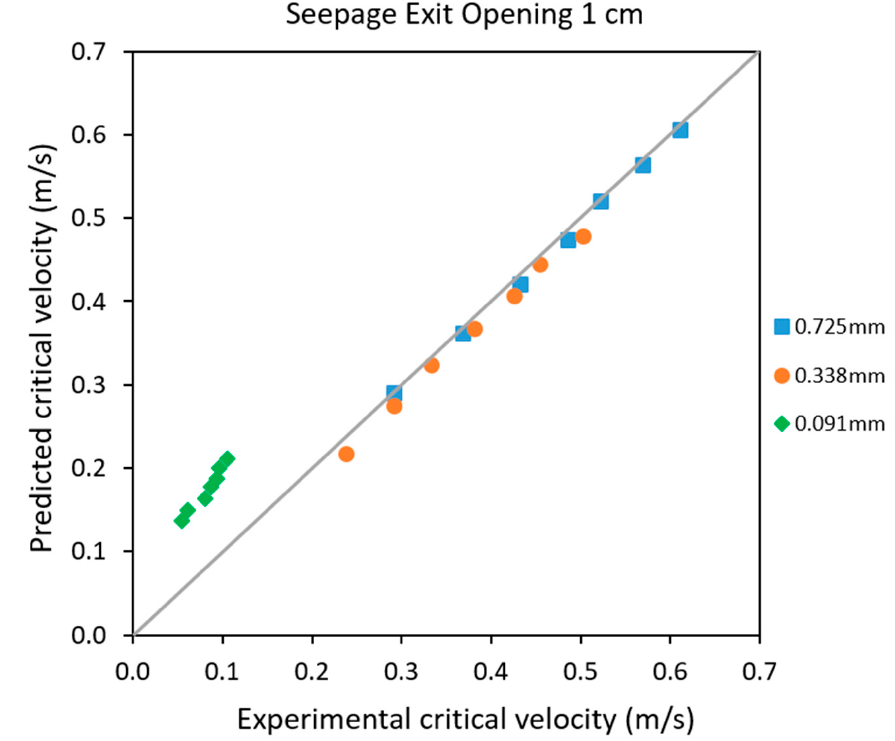
Figure 9. Comparison between predicted and experimental results with the seepage exit opening of 1 cm.